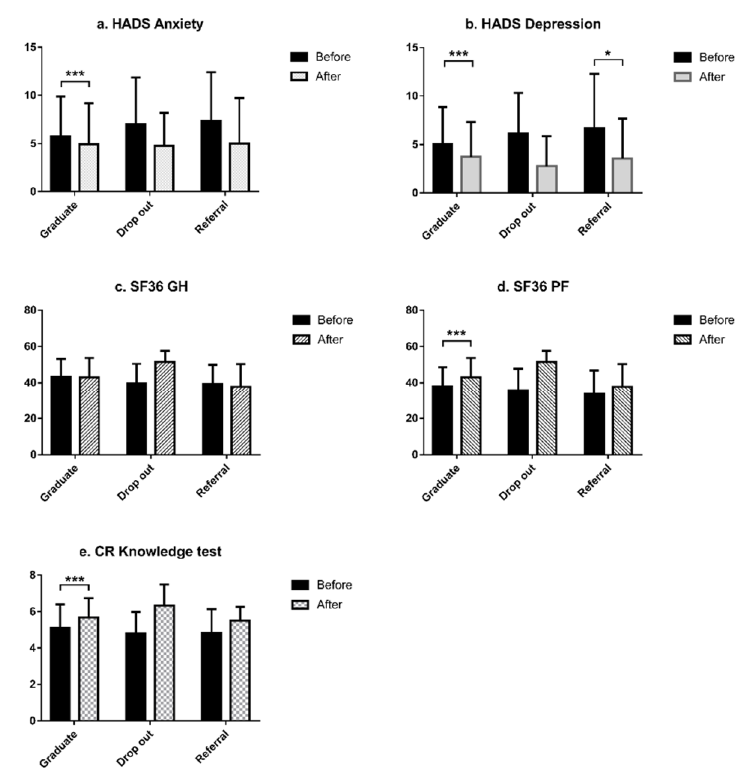
Figure 2. Psychosocial assessment before versus after cardiac rehabilitation in the three patient groups. ( a ) Hospital anxiety and depression scale (HADS) anxiety di ff erences in paired t tests; ( b ) HADS depression di ff erences in paired t tests; ( c ) Short Form 36 for general health (SF36GH) di ff erences in paired t tests; ( d ) Short Form 36 for physical functioning (SF36PF) di ff erences in paired t tests; and ( e ) cardiac rehabilitation (CR) knowledge test di ff erences in paired t -tests. * p < 005, *** p <